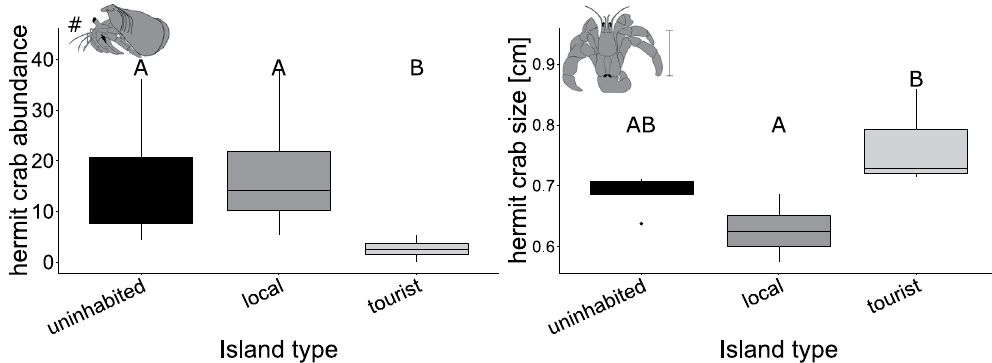
Figure 1. Anthropogenic impact on the abundance and size of hermit crabs. Hermit crab abundance (left) and hermit crab size (right) compared between uninhabited, local and tourist islands ( N = 4). Significant differences between island types are indicated by different